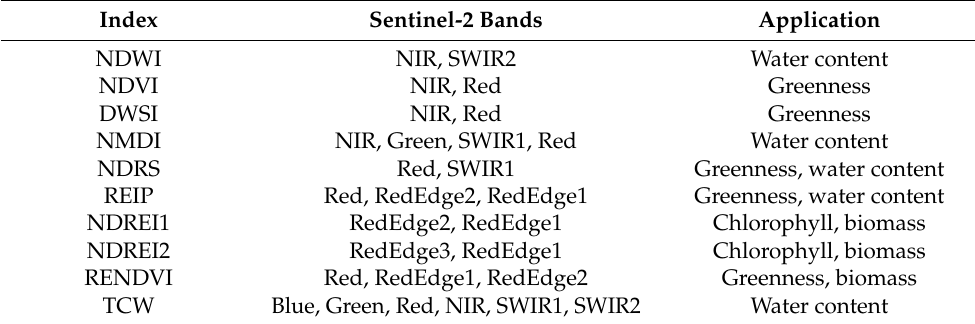
Table 2. Vegetation indices tested in this